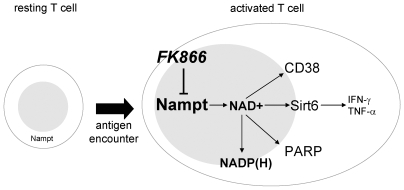
A putative model of Nampt's role in activated T lymphocytes.Nampt activity is responsible for providing sufficient NAD+ supplies during T cell activation. NAD+, in turn, is required for ATP synthesis, metabolic reactions, and to replenish NADPH levels. In addition, NAD+ represents the substrate of NAD+-degrading enzymes such as PARP, CD38, and the sirtuins. Among these, Sirt6 appears to have a central role in IFN-γ and TNF-α production. Nampt inhibitors such as FK866 (and possibly Sirt6 inhibitors) could be used to modulate T cell-mediated immune responses and thereby be beneficial in immune disorders.